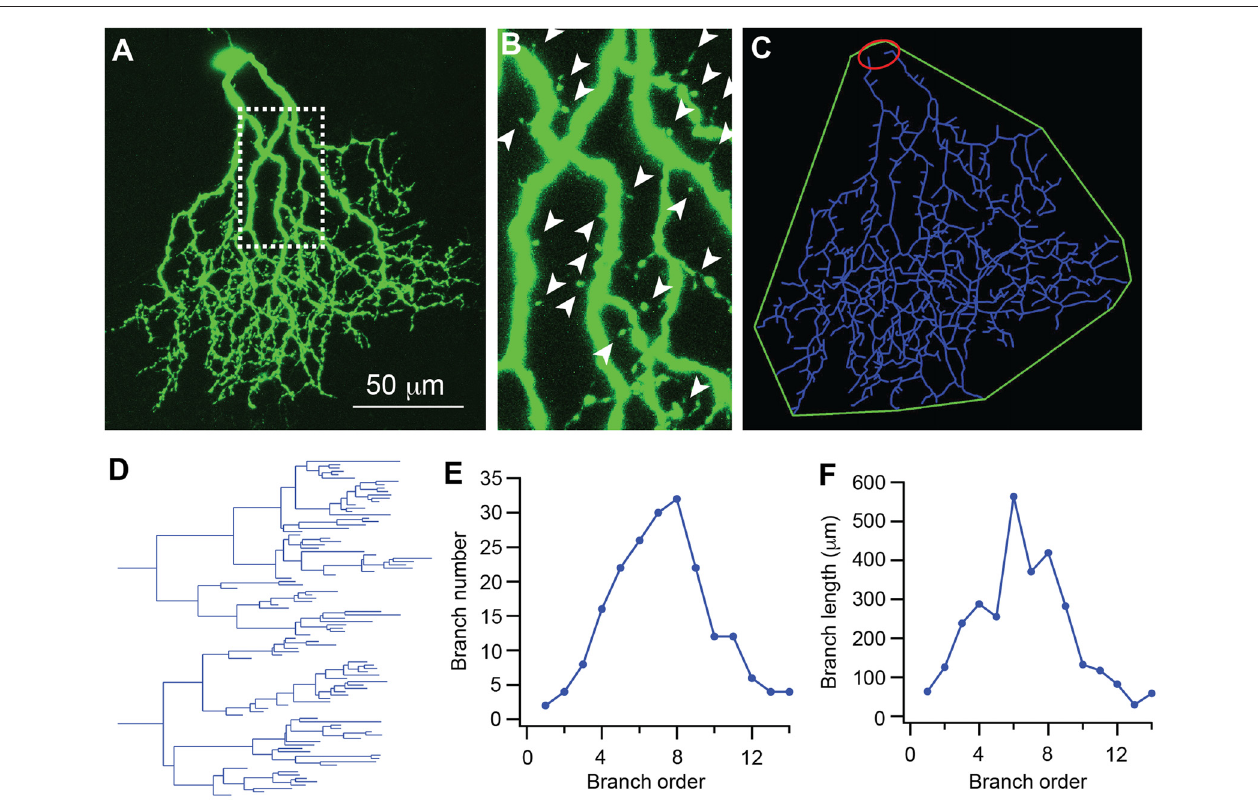
FIGURE 2 | The dendritic pattern of J-RGCs is quantitatively analyzed. The dendritic pattern of J-RGCs was quantitatively analyzed. (A) Maximum projection of the confocal image of a J-RGC. (B) An enlarged view of the dendrites indicated by the dashed line box of (A) showing the dendritic protrusion (arrowheads). (C) The tracing result of the J-RGC showing the soma (red), the dendrites (blue), and the dendritic field (green). (D) The dendrogram of the tracing result of the J-RGC shown in (C) . The total length of dendrites, the number of dendritic branches, and the number of dendritic protrusions were quantified based on this dendrogram. (E) The plot of the number of dendritic branches as a function of branch order of the cell in (A) . (F) The plot of dendritic branch length as a function of branch order of the same cell in (A)